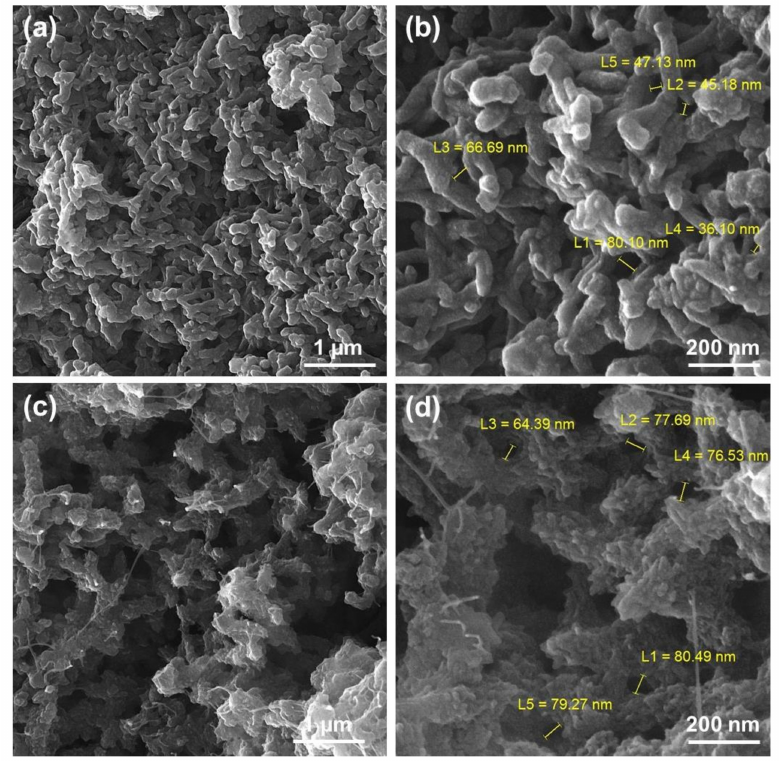
Figure 7. FESEM images of ( a ) and ( b ) PANi and ( c ) and ( d ) PANi-GO-ITN